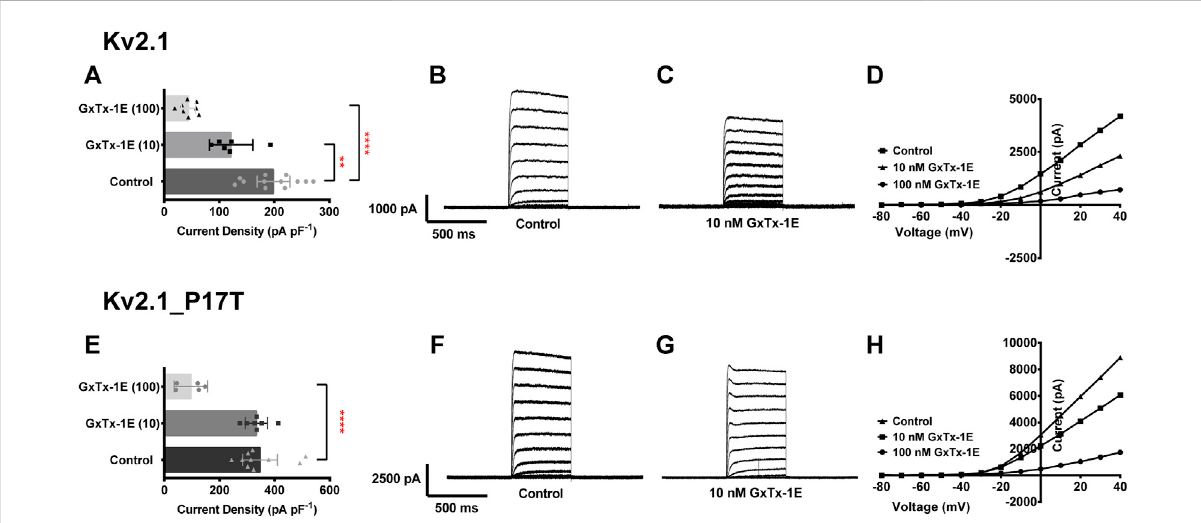
FIGURE 6 P17T mutation alterstheeffectiveness ofthe K V 2.1 channelblocking toxin, guanxitoxin-1E (GxTx-1E). (A) Histogram ofcurrent density (pA pF-1) measured at+50 mV from individual cells, transiently expressing 500 ng of K V 2.1-WT in control solution ( n = 12), 10 nM GxTx-1E ( n = 6) and 100 nM GxTx-1E ( n = 8). Error bars represent 95% CI. Statistical signi fi cance was tested using a one-way ANOVA with a post-hoc Dunnett ’ s multiple comparisonstest, p < .05for**and p < 0.001for****. (B,C) Averagewhole-cellcurrenttracerecordedusingprotocolAwhenexpressingK V 2.1- WT in the absence (B) and presence (C) of 10 nM GxTx-1E. (D) Representative current voltage relationships for cells expressing K V 2.1-WT in control solution, 10 nM GxTx-1E and 100 nM GxTx-1E. (E) Histogram of current density (pA pF − 1 ) measured at +50 mV from individual cells,